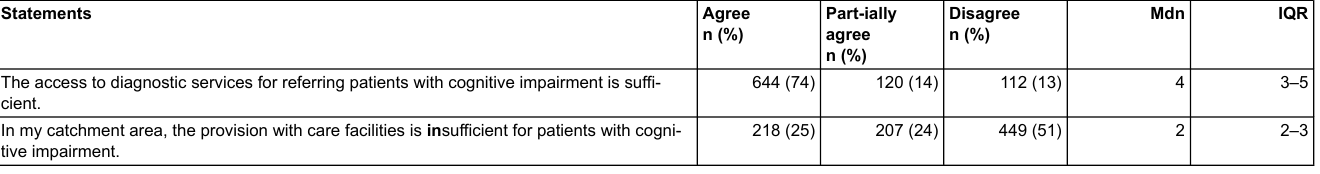
Table S3: Agreement with statements about regional provision with health care facilities.